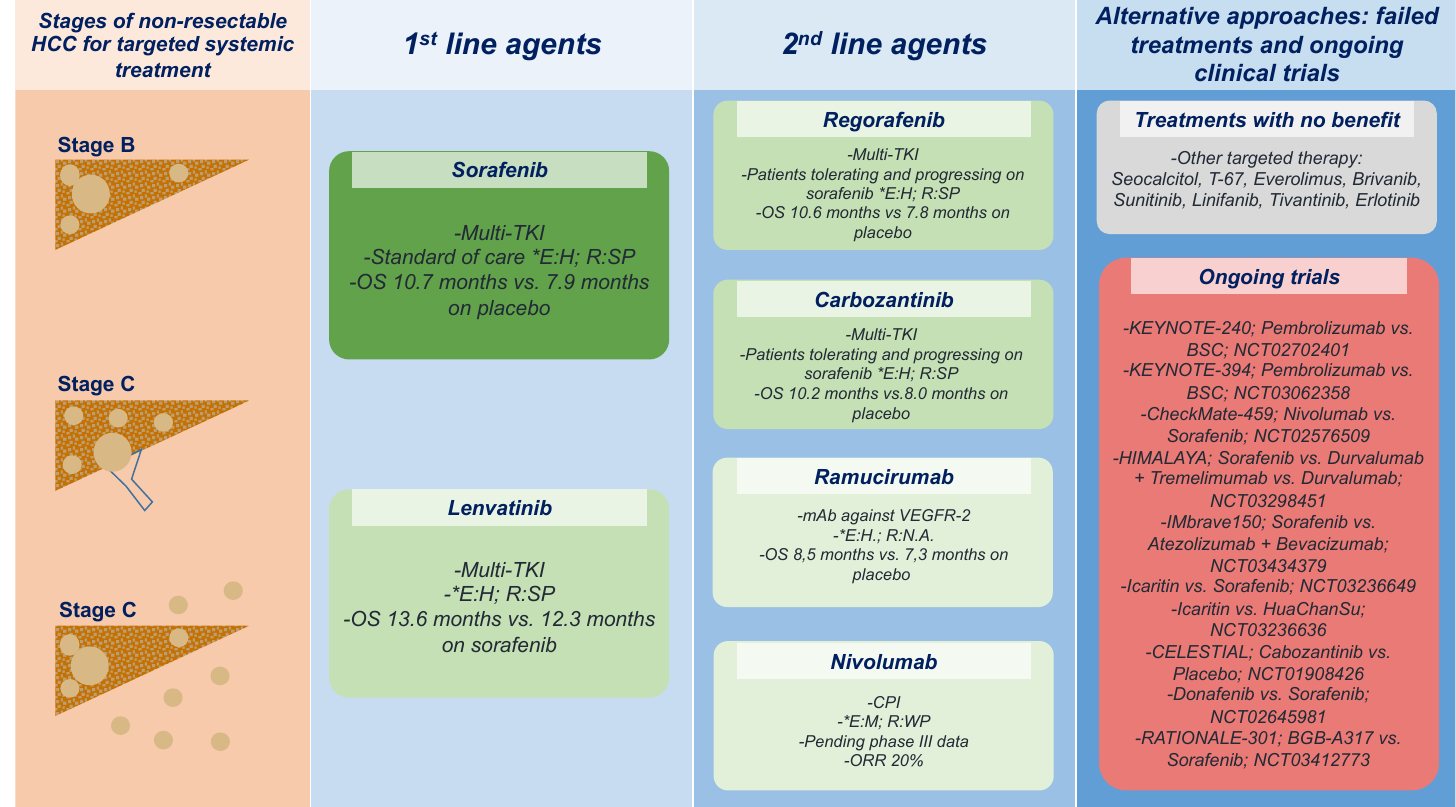
Figure 2. Systemic targeted therapy options for intermediate and advanced HCC. BCLC Stage B (multinodular) and Stage C (portal vein invasion or